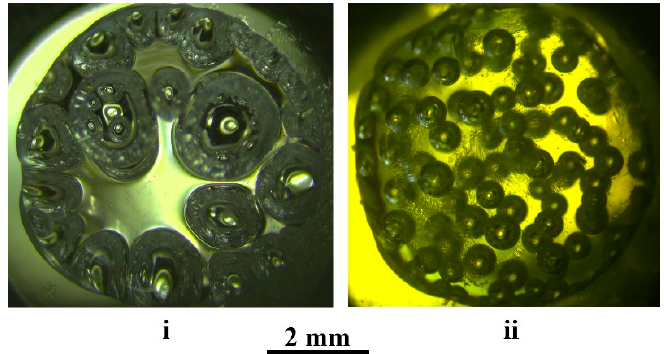
Figure 1. Samples of the quasi-isothermally foamed d,l-polylactide at the beginning of an intensive foam expansion. i— P in = 6.0 MPa, T = 323 K; ii— P = 11.5 MPa, T = 323 K.